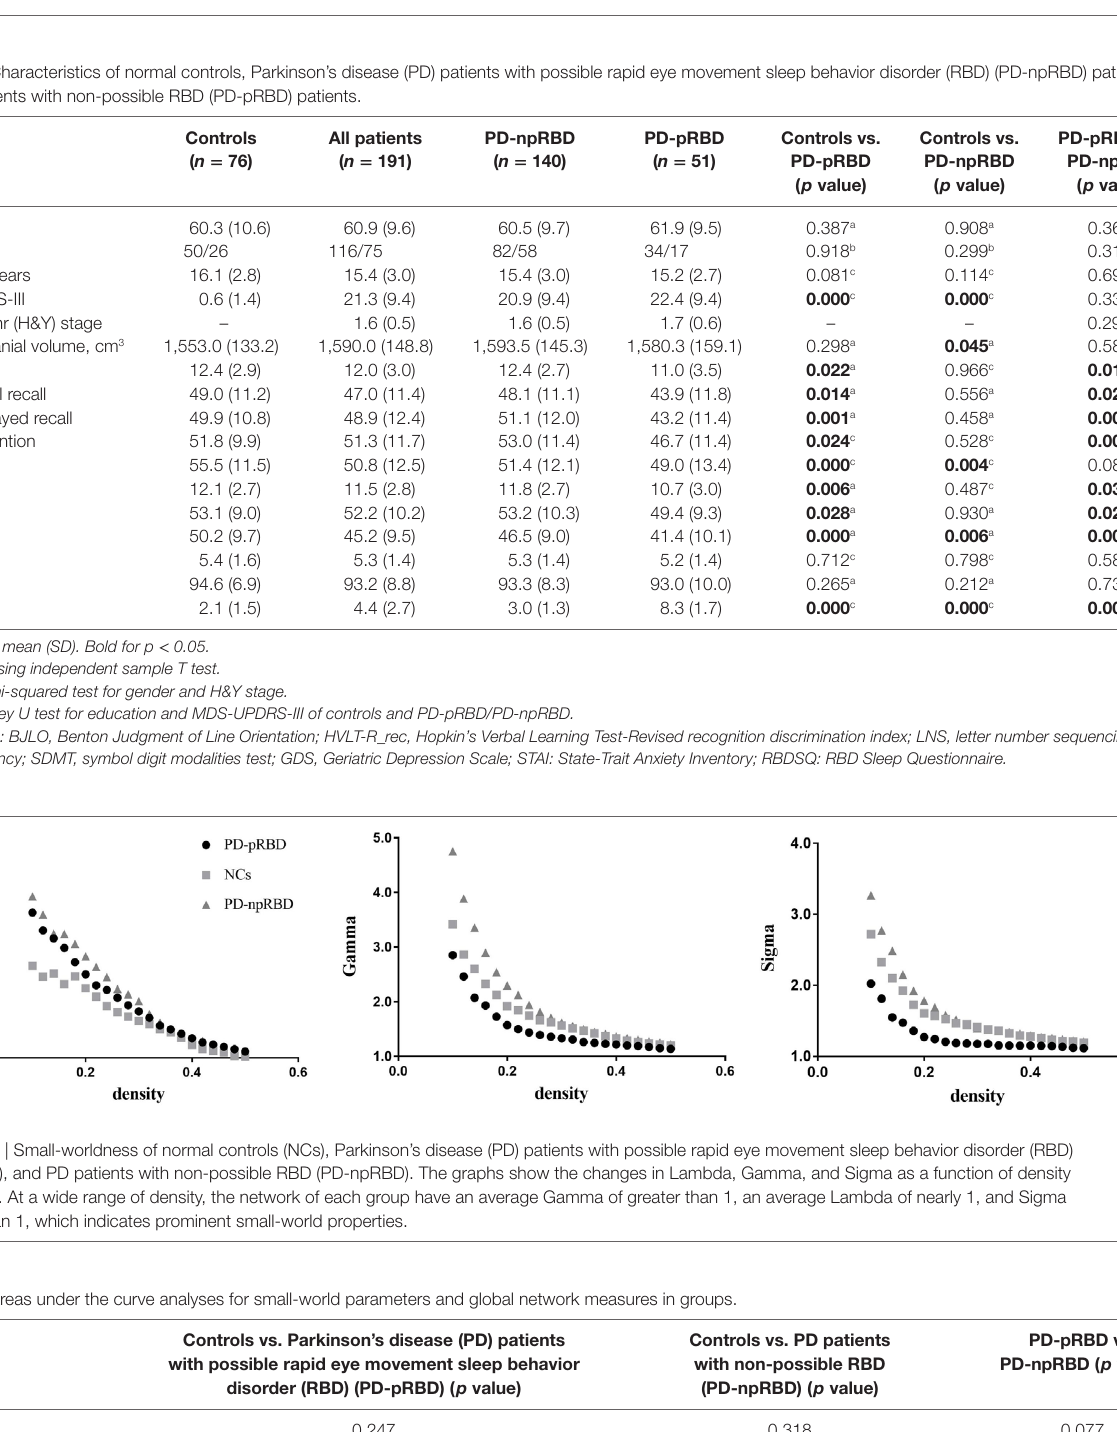
TaBle 1 | Characteristics of normal controls, Parkinson’s disease (PD) patients with possible rapid eye movement sleep behavior disorder (RBD) (PD-npRBD) patients and PD patients with non-possible RBD (PD-pRBD) patients.